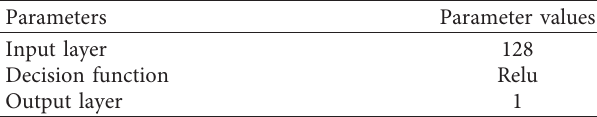
Table 3: Recurrent neural network training parameters.